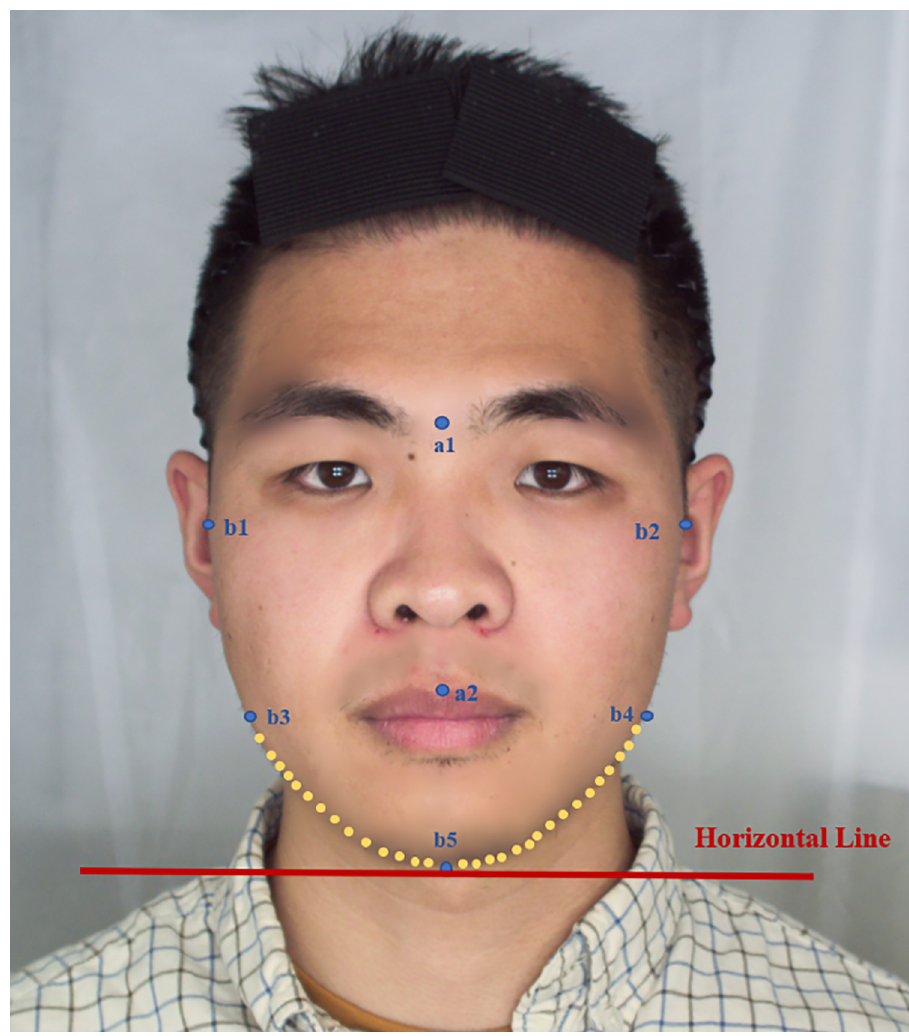
Fig 2. Location of identification indicators related to facial features based on objective measurement data. fWHR = (b1-b2)/(a1-a2) × 100; mandibular line angle: the angle between the fitted line and the horizontal line formed by 50 yellow points; blue point: identification indicator; yellow point: indicator for bilateral mandibular contour recognition; red line: horizontal